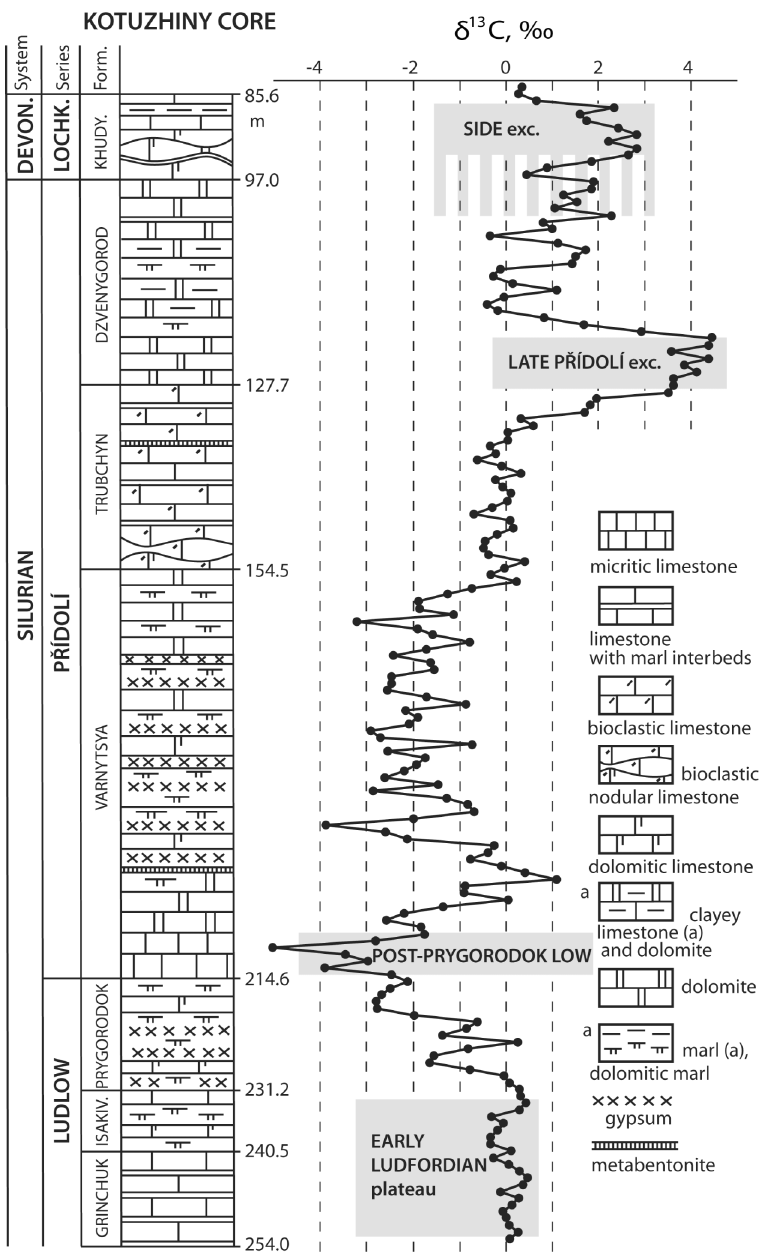
Fig. 3. Carbon isotope trend in the Kotuzhiny drill core: log and lithostratigraphy by V. Grytsenko and L. Konstantinenko (Geological Institute, National Academy of Sciences, Ukraine). For explanations see text. Abbreviations: Devon. (cid:150) Devonian; Lochk. (cid:150) Lochkovian; Khudy. (cid:150) Khudykivtsy; Isakiv. (cid:150) Isakivtsy. Grey belts mark isotope events, the striped belt is a questionable part of the